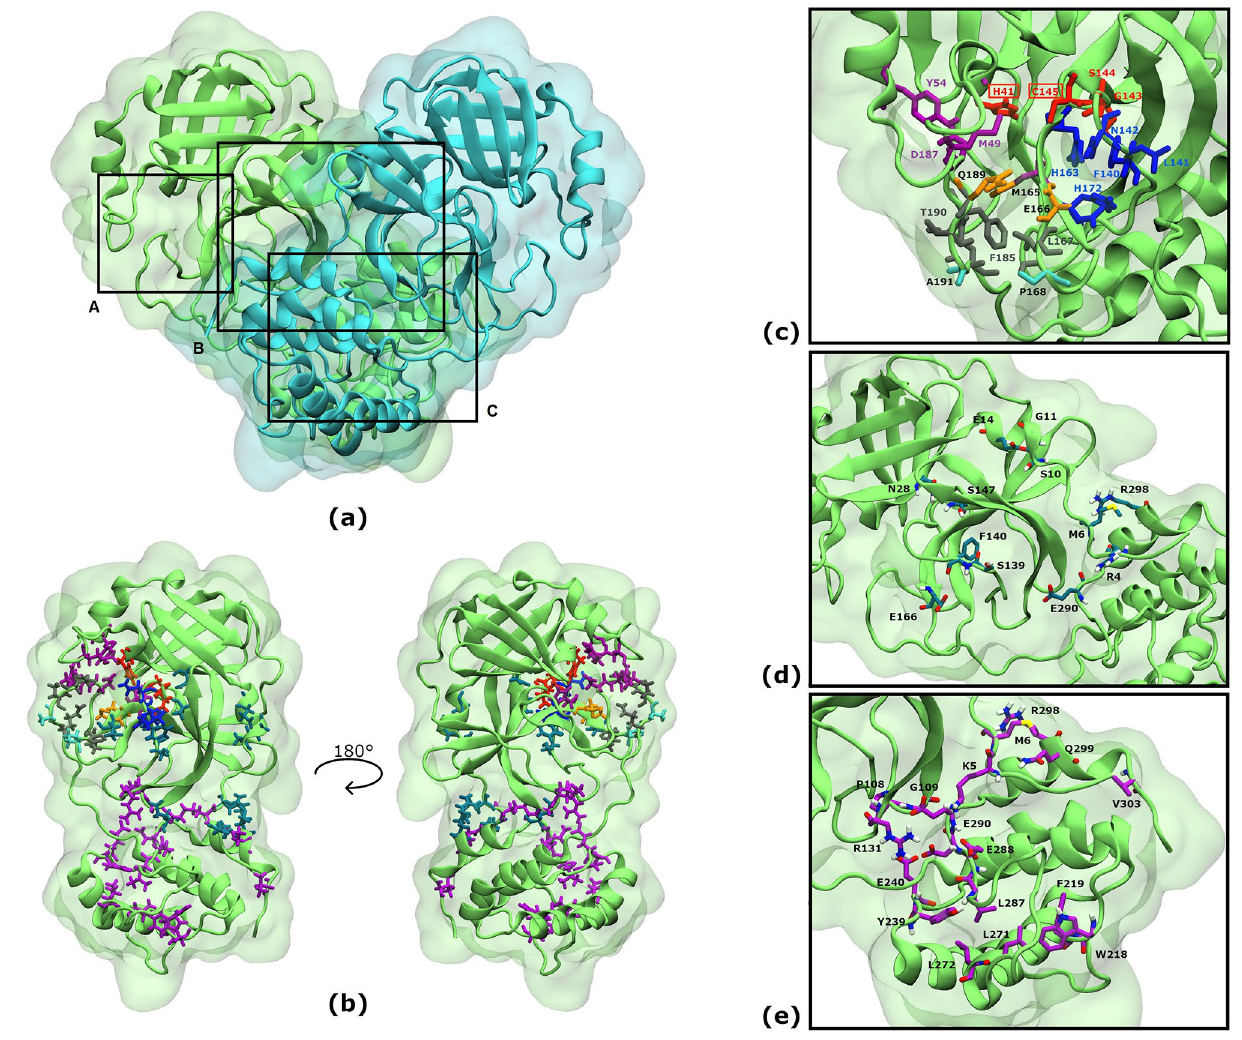
Figure 1. SARS-CoV-2 M PRO and its three Putative Binding Sites (PBS). ( a ) Protomers are in cartoon and surface representations, each in a different colour; black boxes indicate the position of PBSs: (A) Substrate Binding Site, (B) Dimer Site, (C) Cryptic Site. ( b ) Residues conforming the binding sites are depicted in the green protomer as sticks according to colour code: blue for dimerization and magenta for cryptic binding sites, respectively. Substrate binding site residues and labels are coloured according to 5 different subregions: red (S1’: His41, Gly143, Ser144 and Cys145 13,35 ), blue (S1: Ser1 (from the other protomer, not shown), Phe140, Leu141, Asn142, His163, Glu166 and His172 34 ), purple (S2: His41, Met49, Tyr54, Met165 and Asp187 34 ), orange (S3: Met165, Glu166 and Gln189 11 ), grey (S4: Leu167, Pro168, Phe185, Thr190, Ala191, Gln192 and Gln189 34,36 ) and cyan (S5: Pro168, Ala191 34 ). Residues with two colours belong to two subregions; in this case, text labels are coloured black. ( c ) Close-up view of SBS. Labels from catalytic residues are enclosed in a red rectangle. ( d ) Close-up view of DS. DS residues were defined according to the literature 7 : Arg4, Met6, Ser10, Gly11, Glu14, Asn28, Ser139, Phe140, Ser147, Glu166, Glu290 and Arg298. ( e ) Close-up view of CS. CS residues were predicted using CryptoSite: Lys5, Met6, Pro108, Gly109, Arg131, Trp218, Phe219, Tyr239, Glu240, Leu271, Leu272, Leu287, Glu288, Asp289, Glu290, Arg298, Gln299 and was the best inhibitor with a − 7.29 kcal/mol binding energy. Lastly, CS ligand CHEMBL2171598 was the best inhibitor with a binding energy of − 10.59 kcal/mol. All DS docked ligands inserted at least one aromatic ring into the same small pocket reported in previous studies to bind allosteric inhibitors 9–11 . The cavity will be referred to as region A (Supplementary Fig. 2a,b). CS ligands kurzichalcolactone (FL1CA9NC0001) and CHEMBL2171598 were found to bind region A in the same fashion as the DS docked ligands. Out of the 15 compounds, 7 were ranked within the top 30 in both fast and exhaustive screenings (Supple- mentary Table 3). These included DS and CS best inhibitors. Notably, sanggenol O was ranked first in both stages. Positive and negative controls. A cross docking methodology was used for positive controls to validate the exhaustive-ranking stage. In that sense, non-covalent inhibitors X77, X7V and YD1 were excised from their